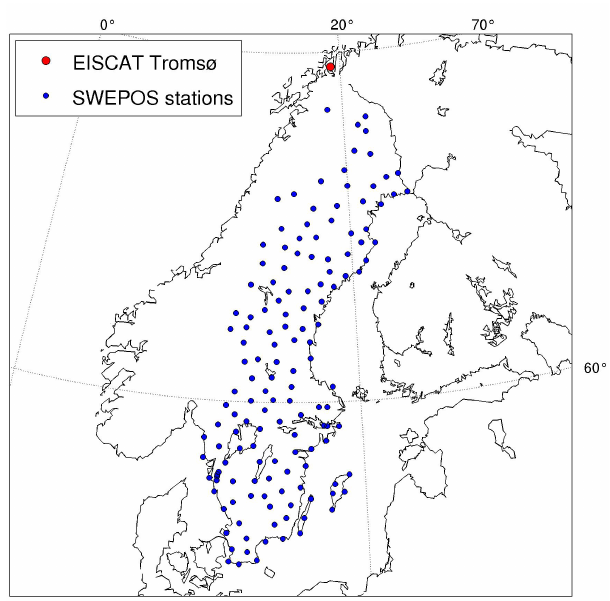
Figure 10. Map of the positions of the GPS receivers in the SWEPOS network, and of the EISCAT incoherent scatter radar in Tromsø. 3 TID detection using